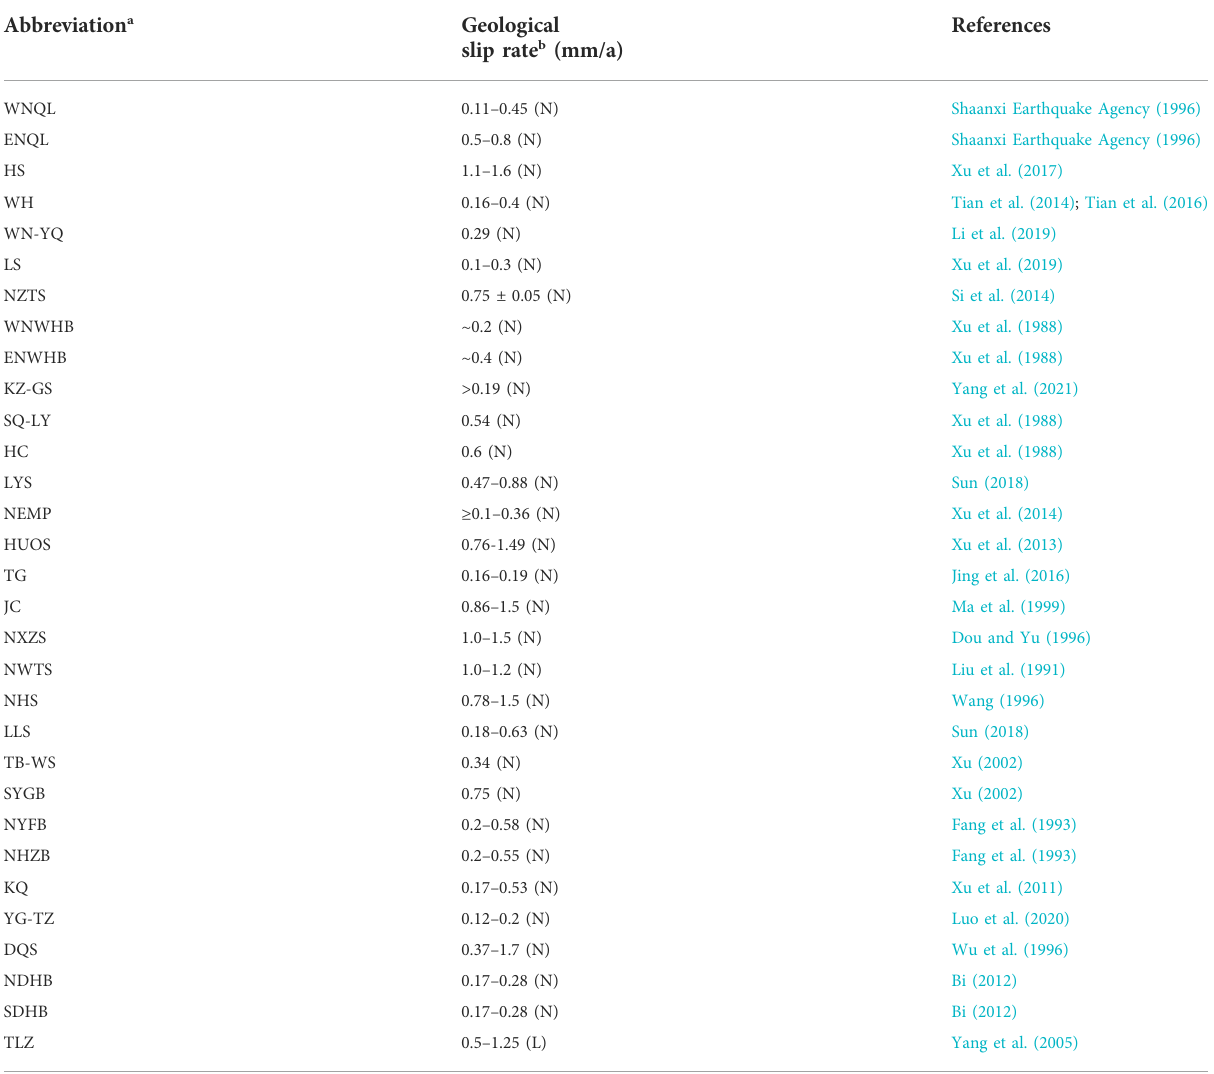
TABLE 1 Geological fault slip rates used in the